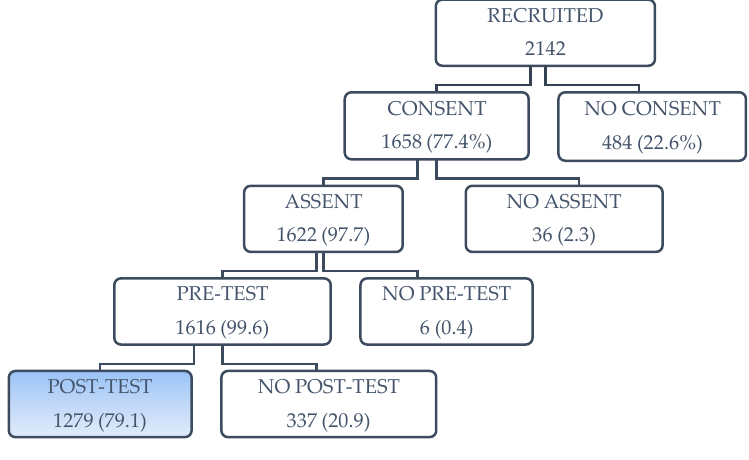
Figure 1. Flow chart of participants.